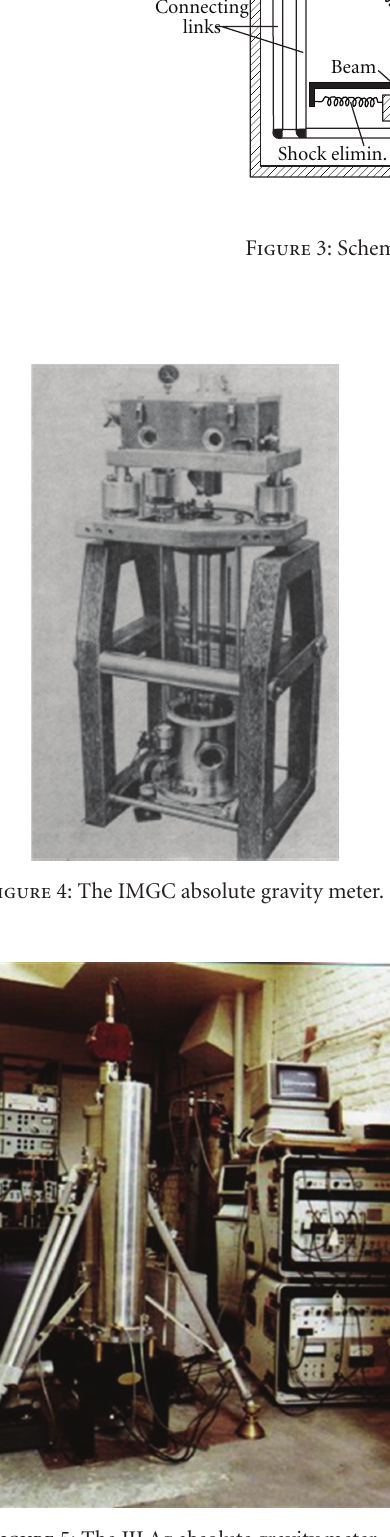
Figure 5: The JILAg absolute gravity meter.